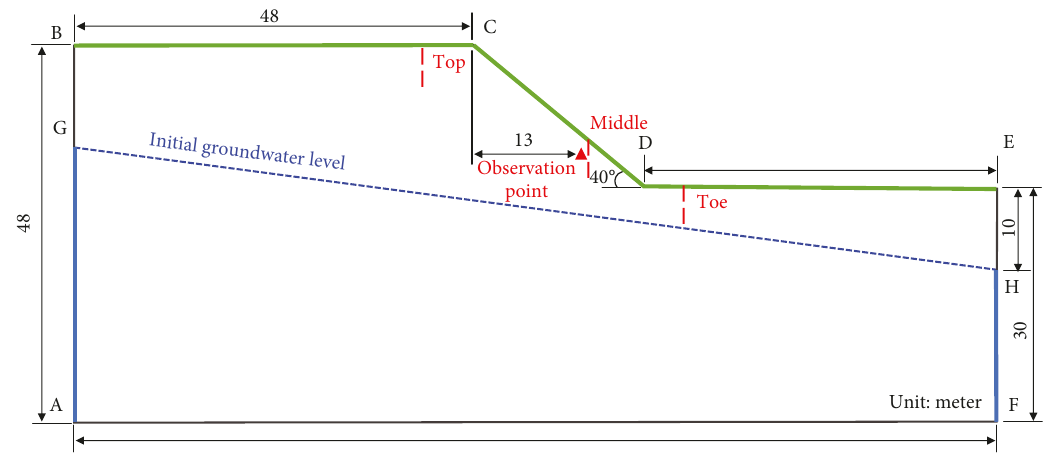
Figure 2: Illustration of the slope conceptual model.